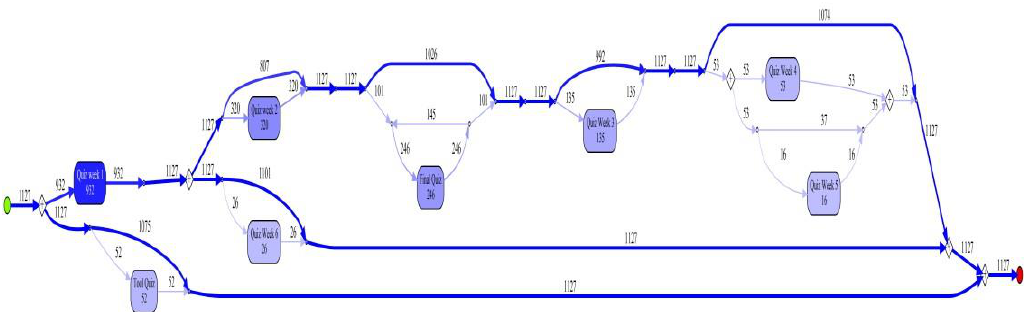
Figure 11. Quiz submission process model for cluster 1.